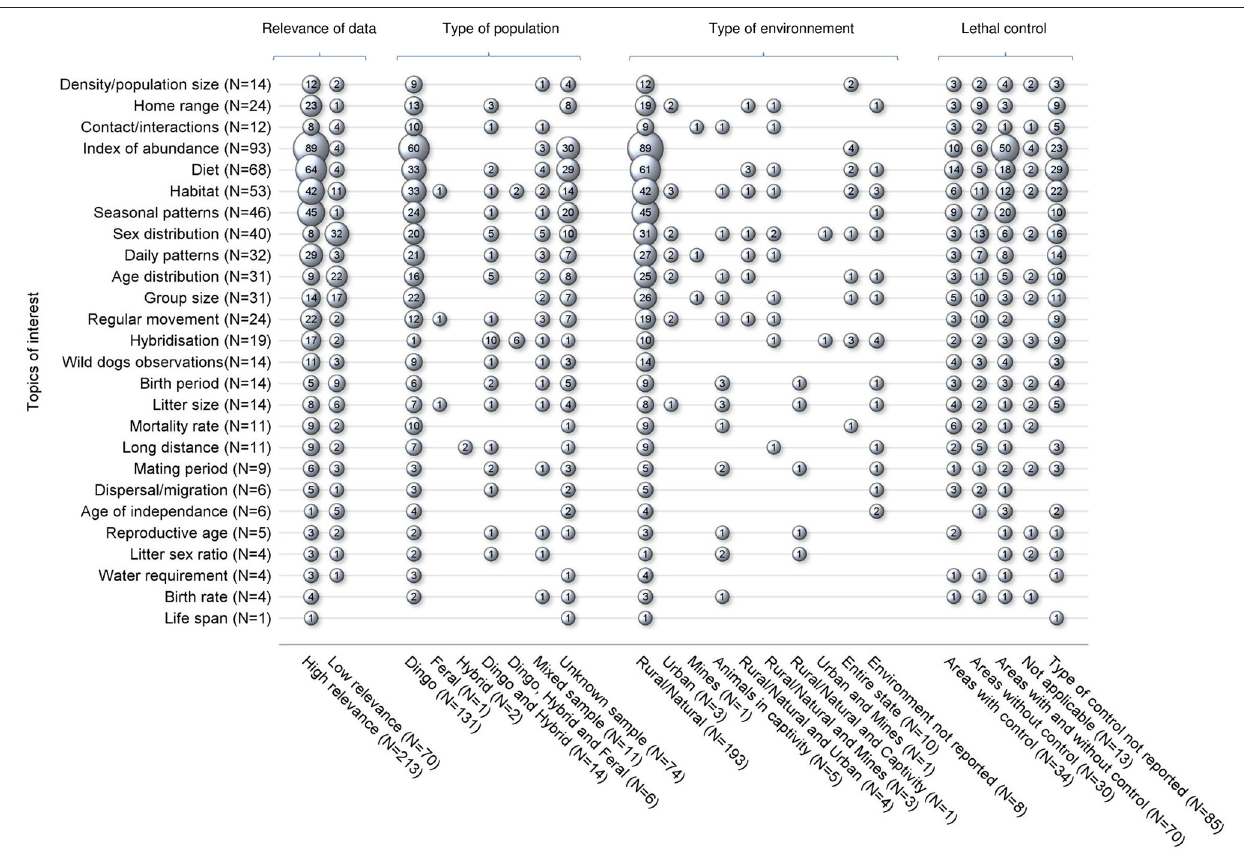
FIGURE 3 | Bubble plot of 229 studies captured from a scoping review on the ecology and biology of dingoes, feral domestic dogs, and dingo-dog hybrids in Australia, targeting 28 specific topics of interest selected to inform disease spread models, in relation to four groupings of data of interest characteristics. Bubble sizes are directly proportional to the number of studies. For each characteristic group, the sum of bubble sizes on each line corresponds to the number of studies reporting data on that particular topic of interest (N). The sum of bubble sizes in each column corresponds to the number of data of interest reported in the literature within that category; N stands for the number of studies reporting at least one data of interest from the corresponding